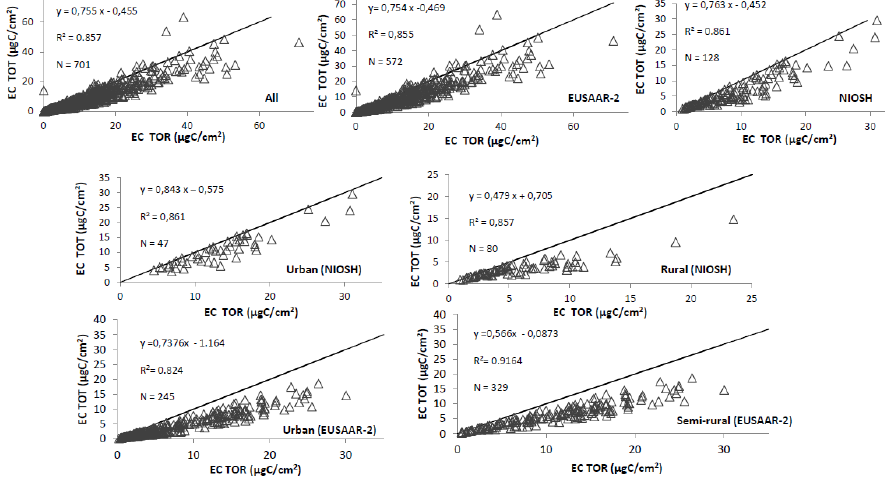
Figure 4. Comparison between reflectance and transmittance for EC for the different samples analysed using EUSAAR-2 (urban and semi-rural samples) or NIOSH (urban and rural samples) protocols. Slope coefficients ( y = ax + b ), correlation coefficients ( R 2 ) and the number of samples ( N ) are given for each graph.